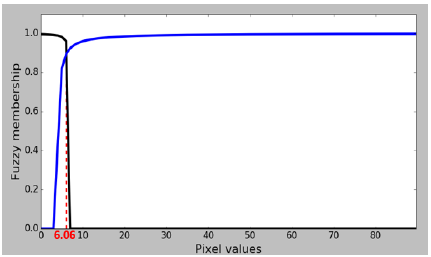
Figure 7. Centroid method for the defuzzification (Black: Water, Land: